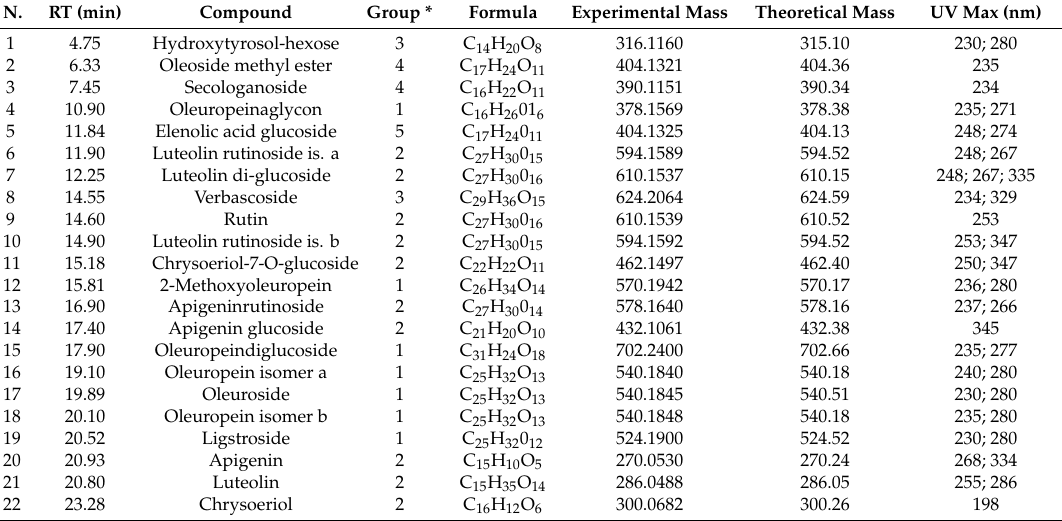
Table 1. List of phenolic compounds putatively identified in the extract of olive leaves from treated plants by LC–MS Q-TOF. Data include compound number (N.) as indicated in Figure 2, retention time (RT, min), phenolic group, experimental and theoretical mass, calculated molecular formula, and UV maximum absorption (nm).